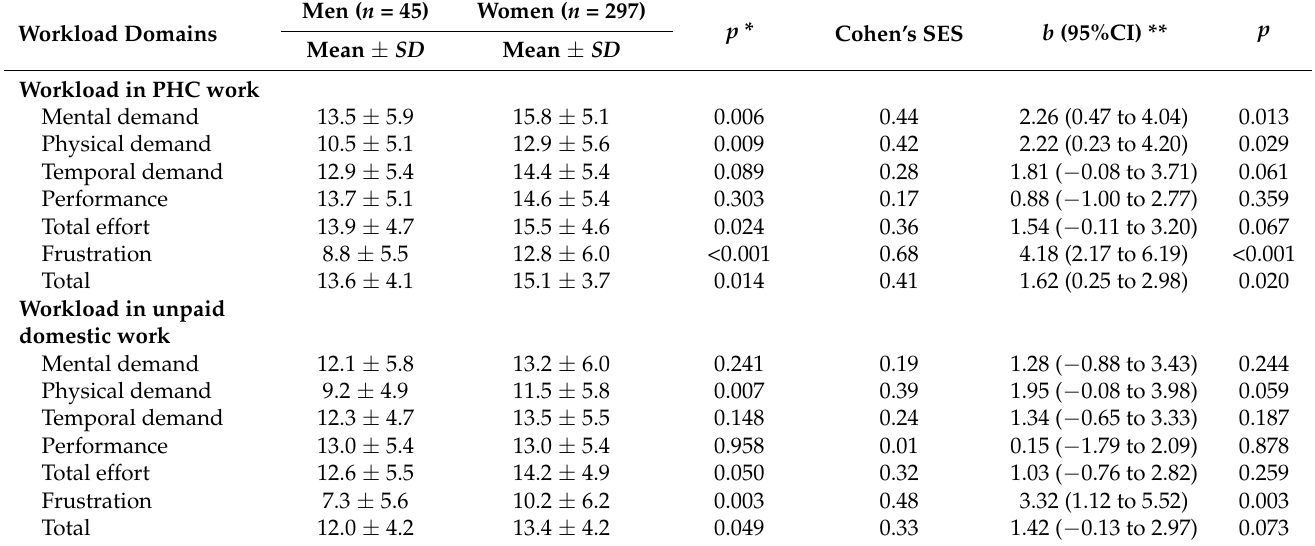
Table 2. Comparison of the gender of health care professionals in terms of PHC workload and unpaid domestic